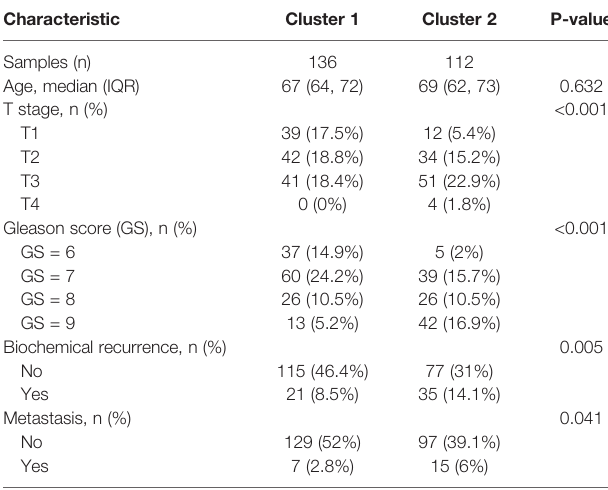
TABLE 2 | The correlations between clinical indicators and clusters in the GSE116918